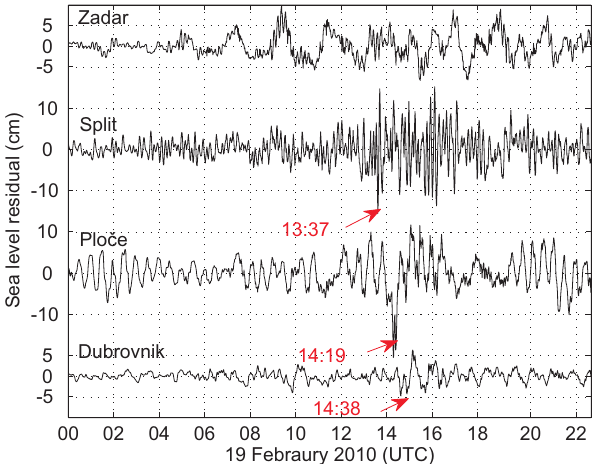
Fig. 2. Sea level time series for Zadar, Split, Ploˇce and Dubrovnik. Series have been filtered with a 3-h Keiser-Bessel filter. Red arrows indicate the arrival time of the first meteotsunami-related sea wave at the stations.